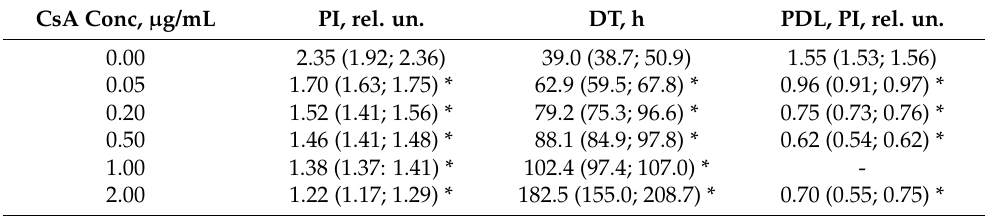
Table 1. HTFs inhibition in control (0.00 µ g/mL) and CsA (0.05–2.00 µ g/mL) groups, Me (Q 1 ; Q 3 ).